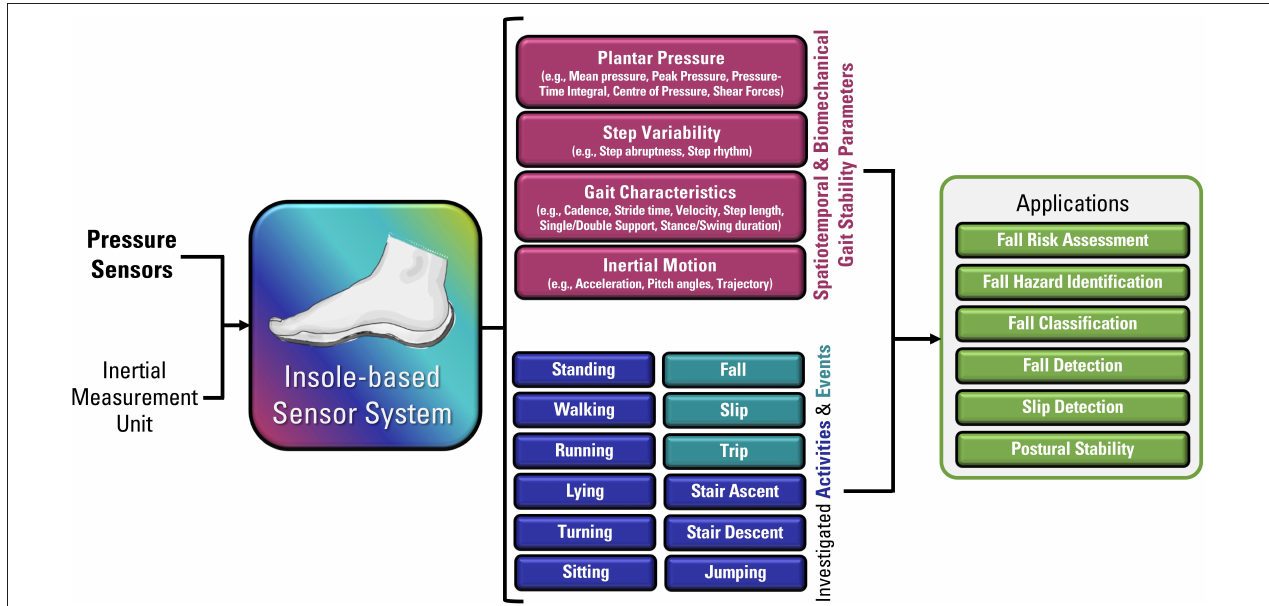
FIGURE 4 | Parameters of interest for fall risk assessment and fall detection using insole-based systems.